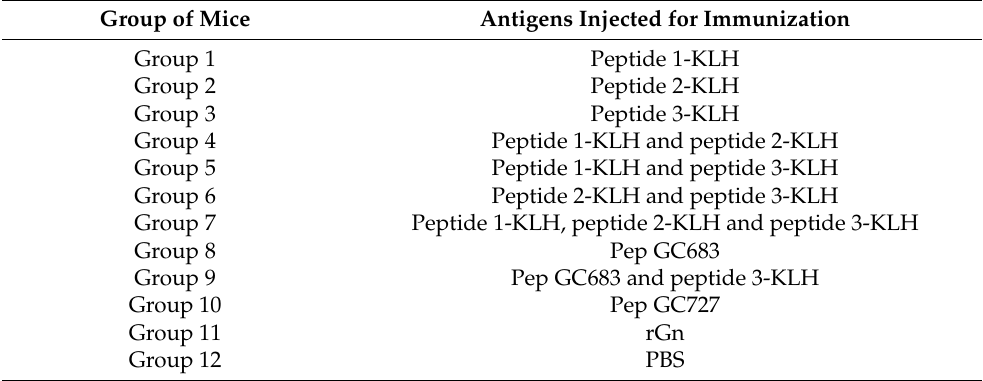
Table 1. Mice immunization